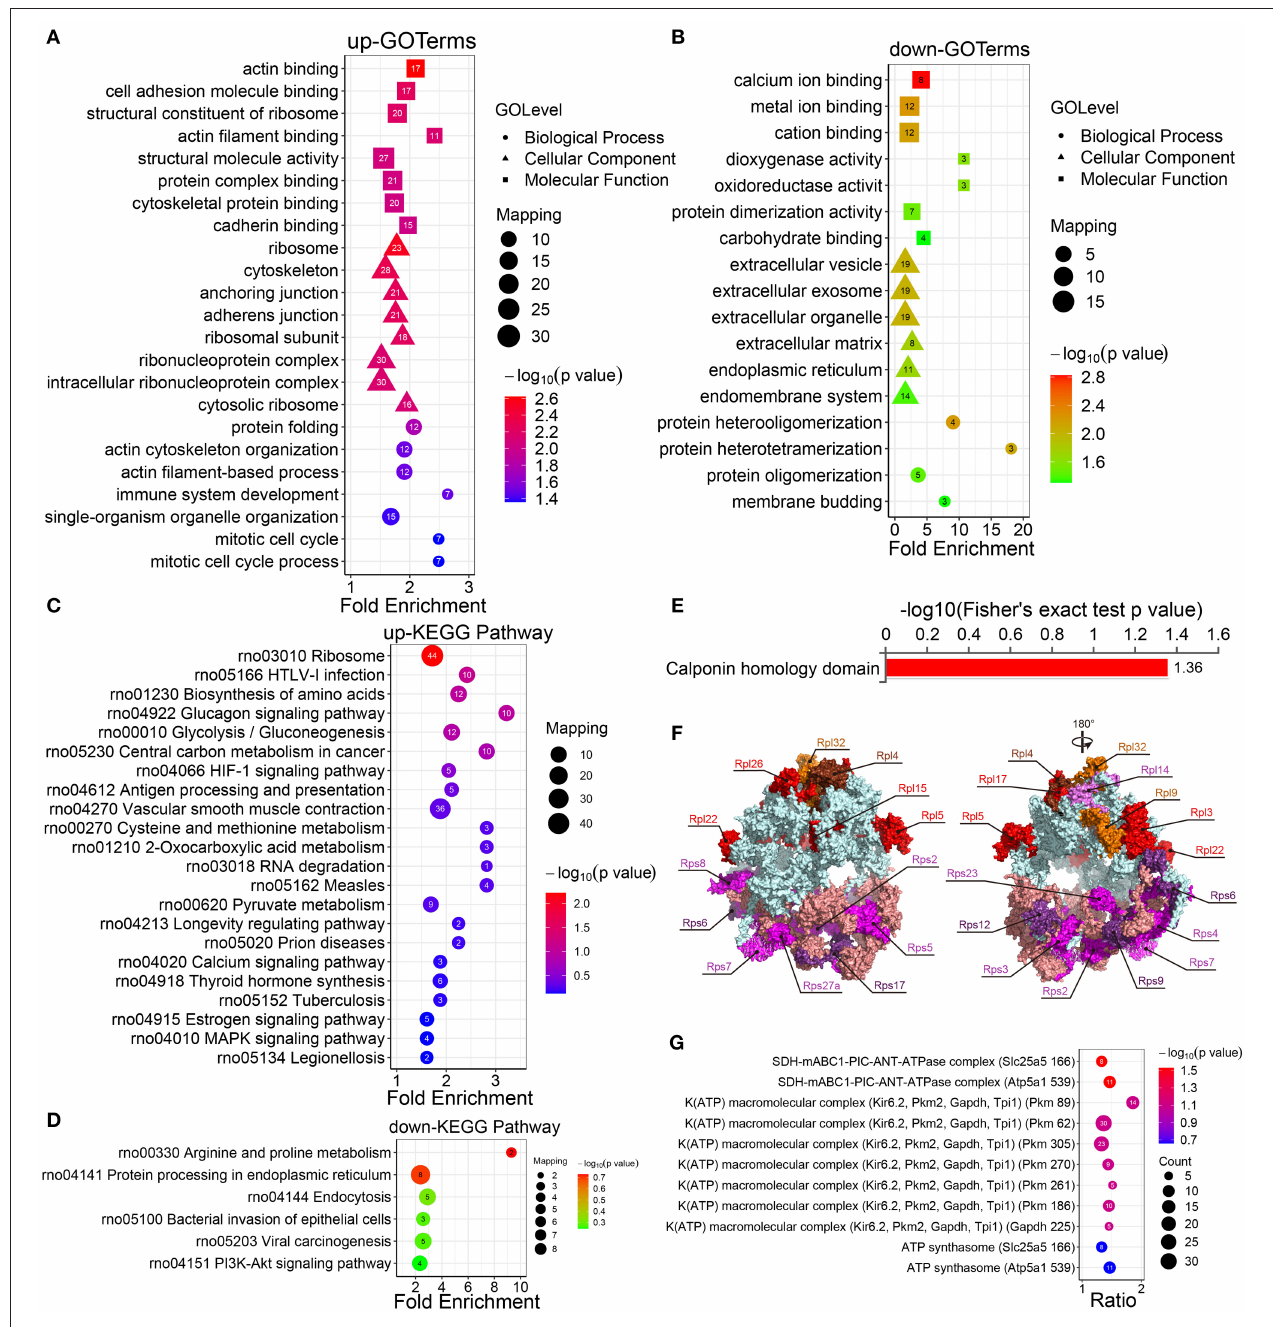
FIGURE 2 | Enrichment analysis of the GO, KEGG pathways, and protein domains of the differentially modified sites. (A) The GO enrichment results of the protein corresponding to the upregulated site and (B) the protein corresponding to the downregulated site. (C) Enrichment analysis of the KEGG pathway of upregulated crotonylated protein. (D) Enrichment analysis of the KEGG pathway of downregulated crotonylated protein. (E) Enrichment analysis of protein domains of upregulated crotonylated protein. (F) The crystal structure of ribosomes and the crotonylated ribosomal proteins (PDB ID: 4V88). (G) Predicted functional enrichment of crotonylated protein complexes. The values on the horizontal axis are “Fold Enrichment” significant p -values ( p < 0.05), which are converted to negative logarithms and then plotted as bubble charts. “ p -value” represents “Fisher’s exact p value.” Rpl, Ribosomal protein large subunit; Rps, Ribosomal protein small subunit.